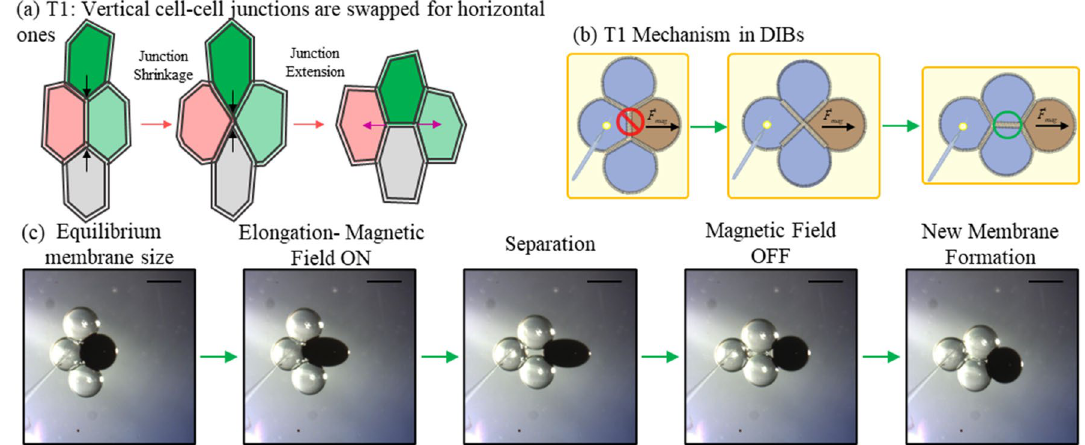
Figure 4. Reconfiguration events in DIB networks. ( a ) The T1 event is a reconfiguration mechanism observed in cellular tissues. Colors are intended to aid in tracking relative cell location. ( b ) Reconfiguration in DIBs mediated through membrane separation/reformation may be produced using magnetic fields. ( c ) Experimental images (top view) obtained when magnetically activating a T1 event in a set of four adhered microdroplets. Scale bar represents 600 μm. The ferrofluid droplet (EMG 507) is pulled towards the activated electromagnet. Once the vertical junction membrane is separated, the magnetic field is turned OFF. After being given sufficient time (around 1 min) a new horizontal membrane junction is formed, similar to the T1 mechanism. Schematic representations in ( a ) and ( b ) were created by the authors using Microsoft